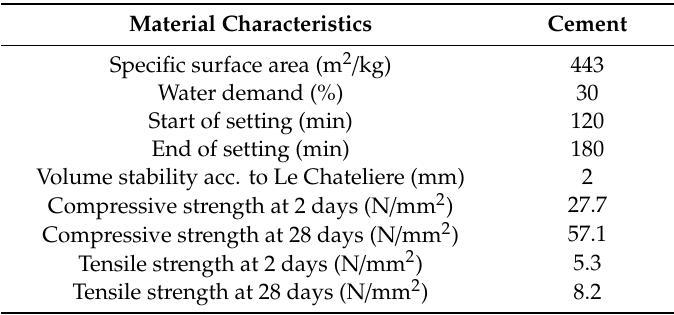
Table 1. Physical properties of cement.